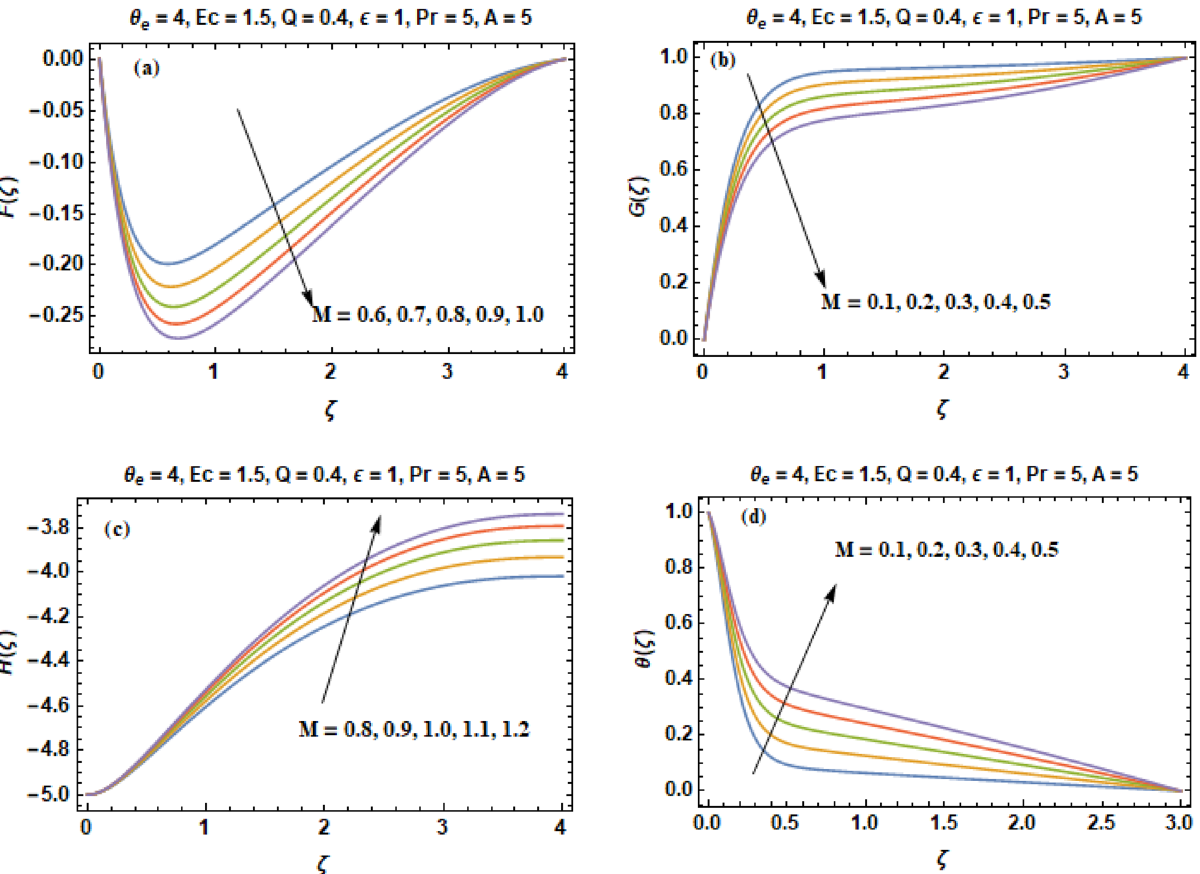
Figure 4. ( a–d ) Constituents of velocity (F, G, H) & temperature profile (θ) versus Magnetic field parameter M